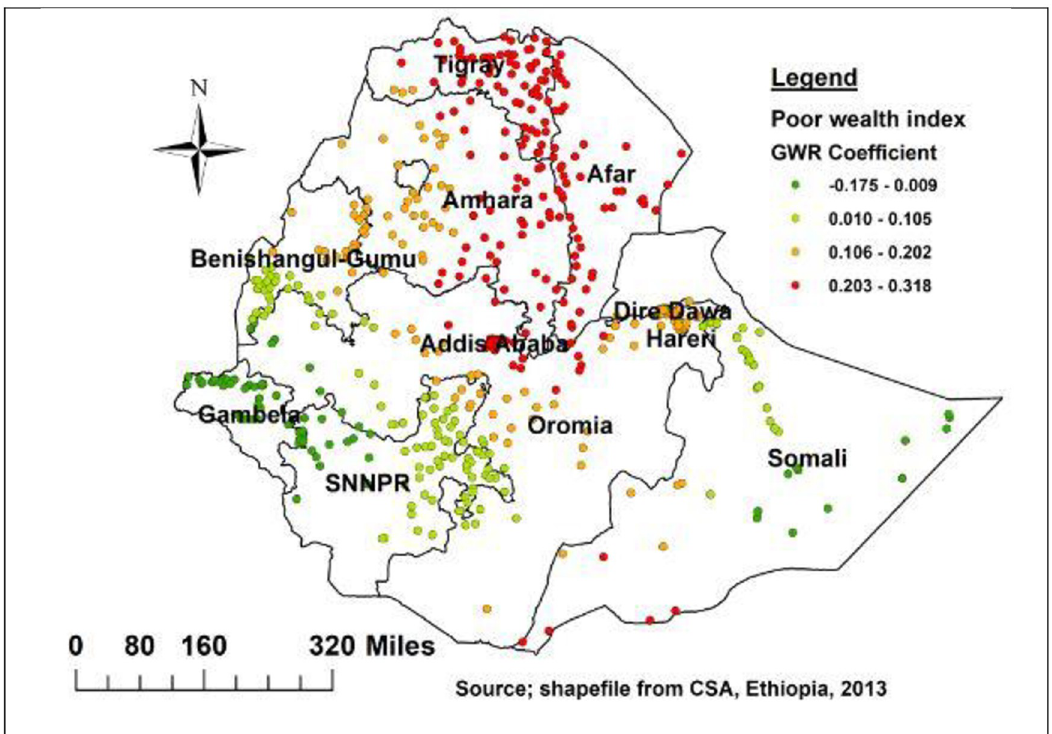
Fig 7. Poor wealth index geographic weighted regression coefficients to predict delayed breastfeeding in Ethiopia.